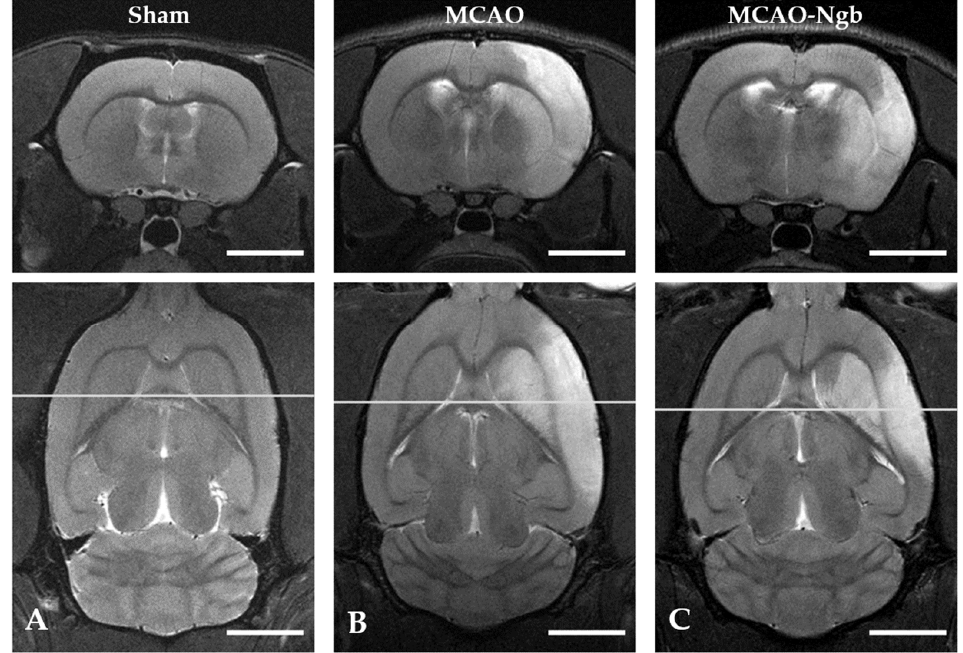
Figure 6. Cerebral T2 axial and coronal neuroimages of sham, MCAO, and MCAO-Ngb animals taken after 24 h of reper- fusion. The infarcted area is visible in images B and C in white, but not in A . Scale bars: 5 mm.